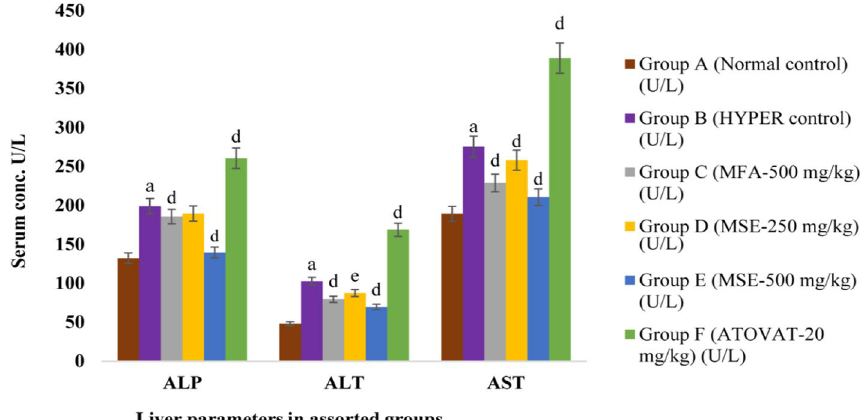
Fig. 4 Comparative expression of liver markers at different conc. of MM extracts in HCD mice. The expression of these markers are mean error of mean (SEM); where n